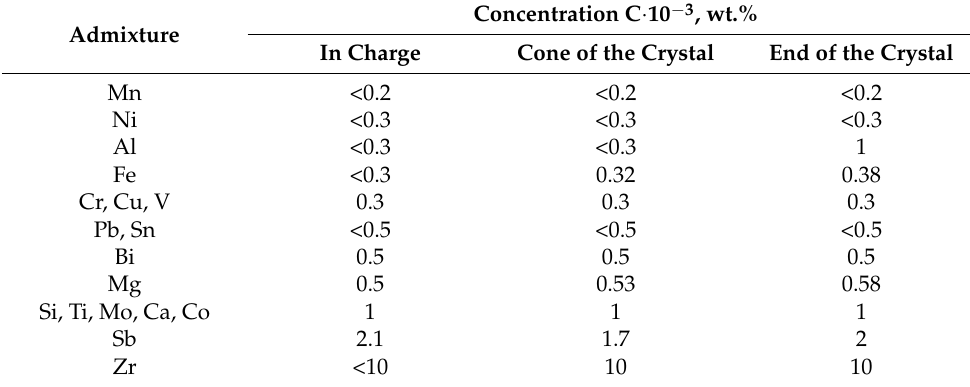
Table 1. Concentrations of admixtures (C, wt.%) in the granular charge, as well as in the cone and end parts of the LiNbO 3 :Gd 3+ (0.003):Mg 2+ (0.65 wt.%) crystal. Concentration C · 10 − 3 , Admixture